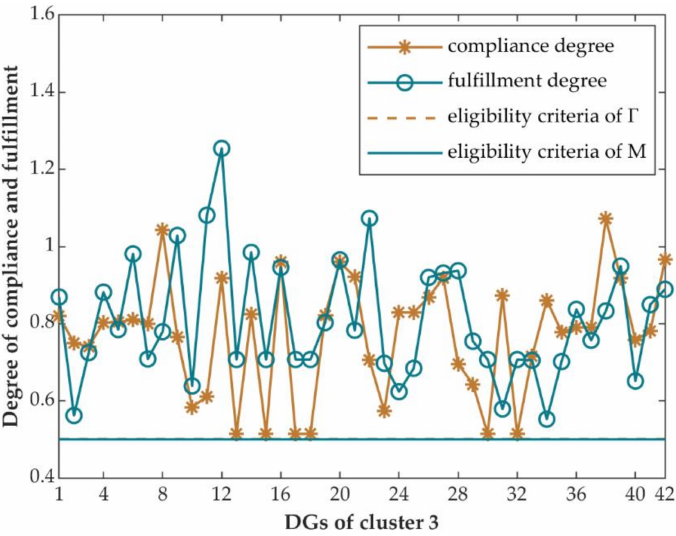
Figure 10. Degree of compliance and fulfillment in cluster